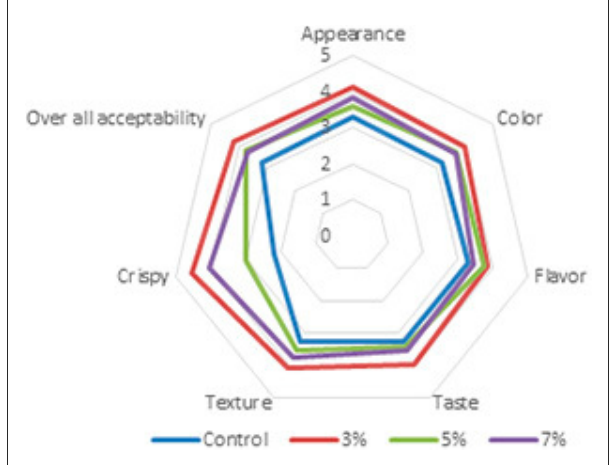
FIGURE3 Spider plot of the sensory-evaluation scores of different levels of apple peels as coating films for deep-fried falafel balls.